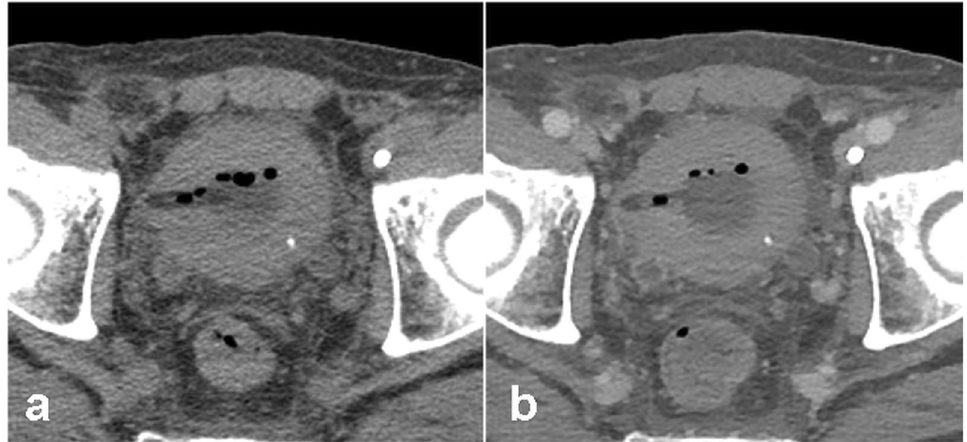
Fig. 15 A 65‑year‑old male patient with eosinophilic cystitis. Axial pre‑contrast ( a ) and contrast‑enhanced ( b ) CT images showing diffuse mural thickening of the bladder wall, which is nonspecific and difficult to distinguish from other cystitis or